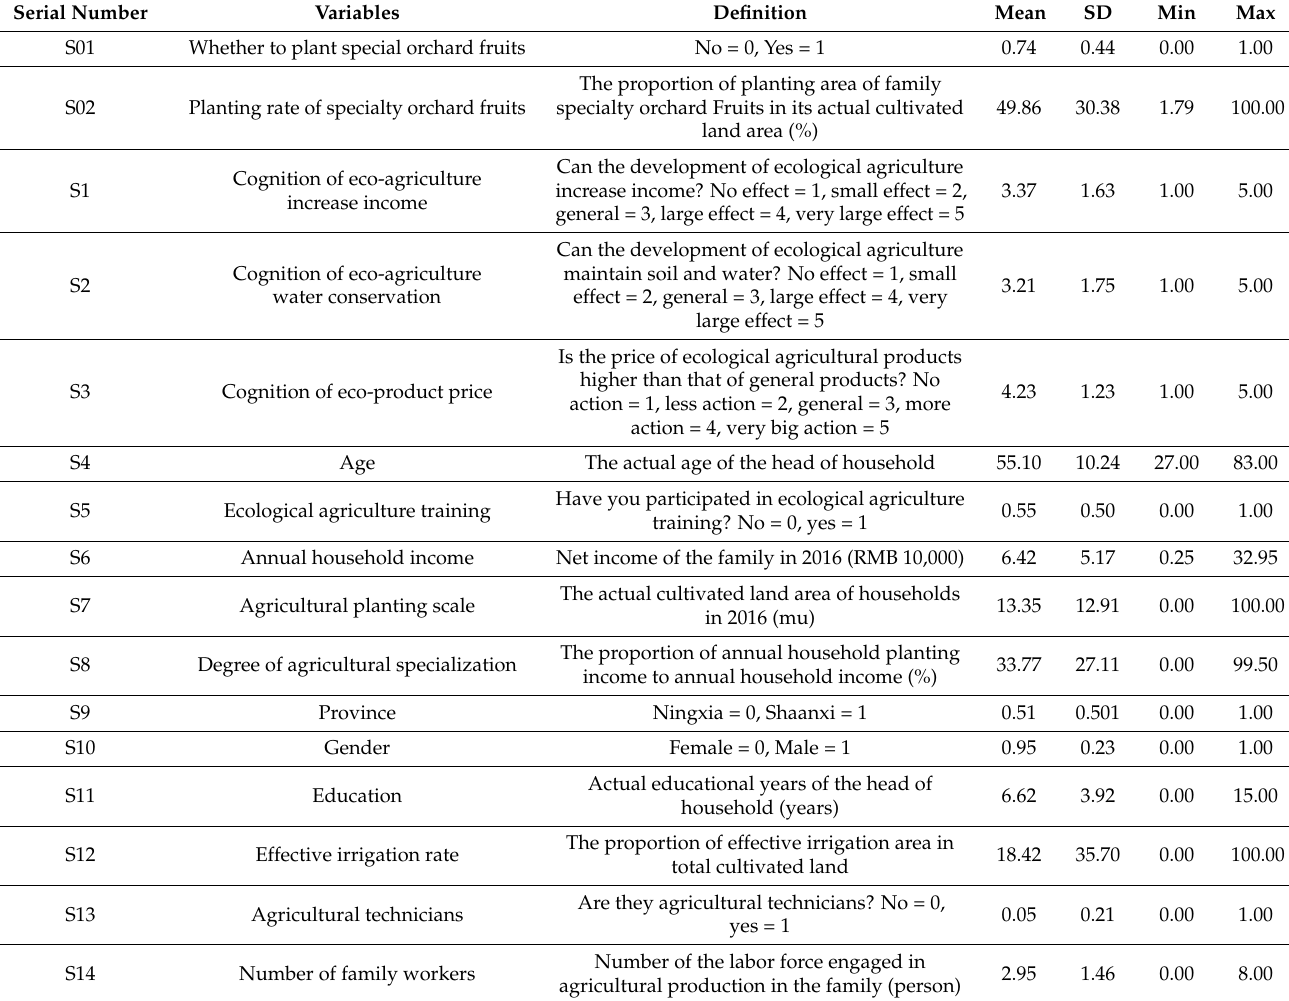
Table 1. Variable meaning and description